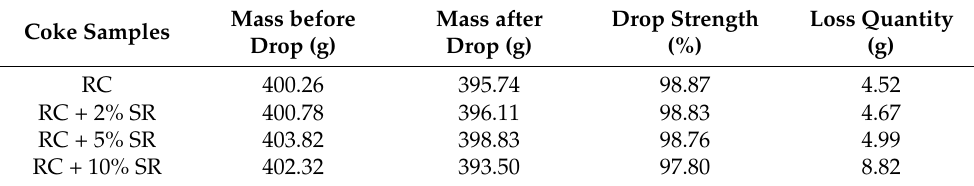
Table 3. Falling strength of different coke